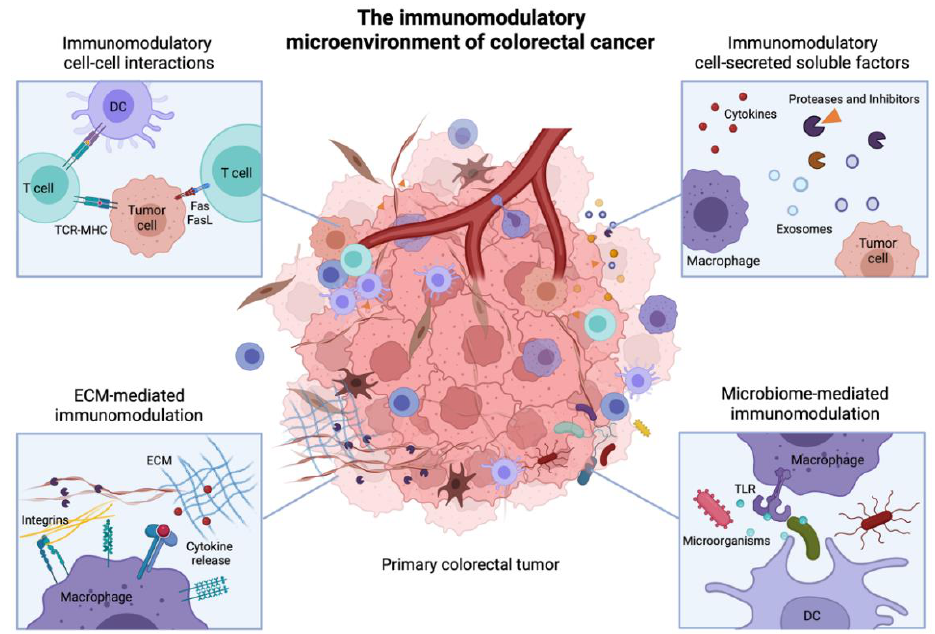
Figure 1. Overview of the key types of molecular interactions with immunomodulatory functions in the TME of colorectal tumors. Immunomodulation in the TME is dynamically regulated by cell-cell interactions, cell-secreted soluble factors, ECM-mediated interactions, and interactions with the microbiome (ECM: extracellular matrix; DC: dendritic cell).